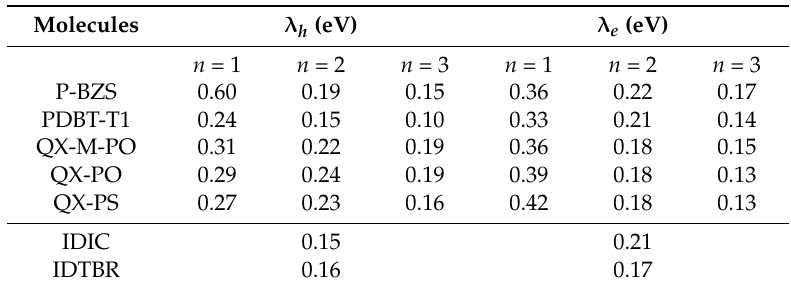
Table 5. The reorganization energies of oligomers ( n = 1–3) and the NFAs.